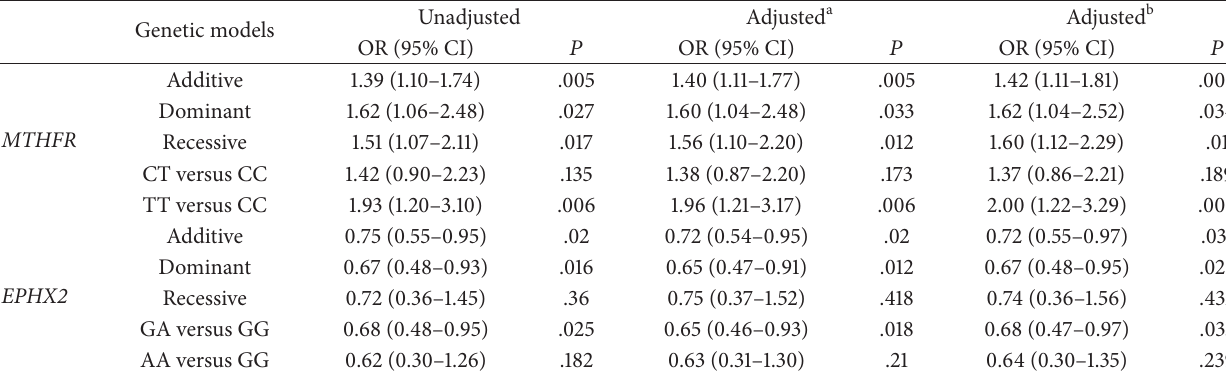
Table 3: Odds ratios and 95% confidence interval for ischemic stroke under three genetic models. Genetic